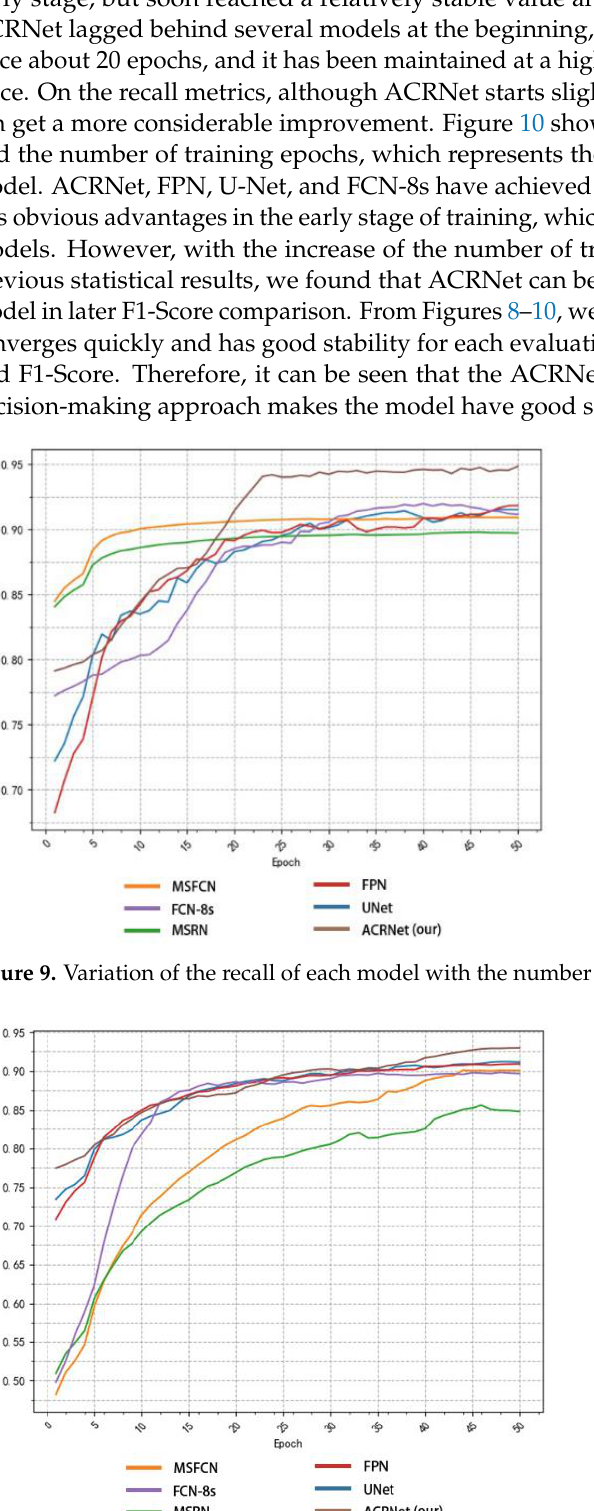
Figure 10. Variation of the F1-Score of each model with the number of training epoch.